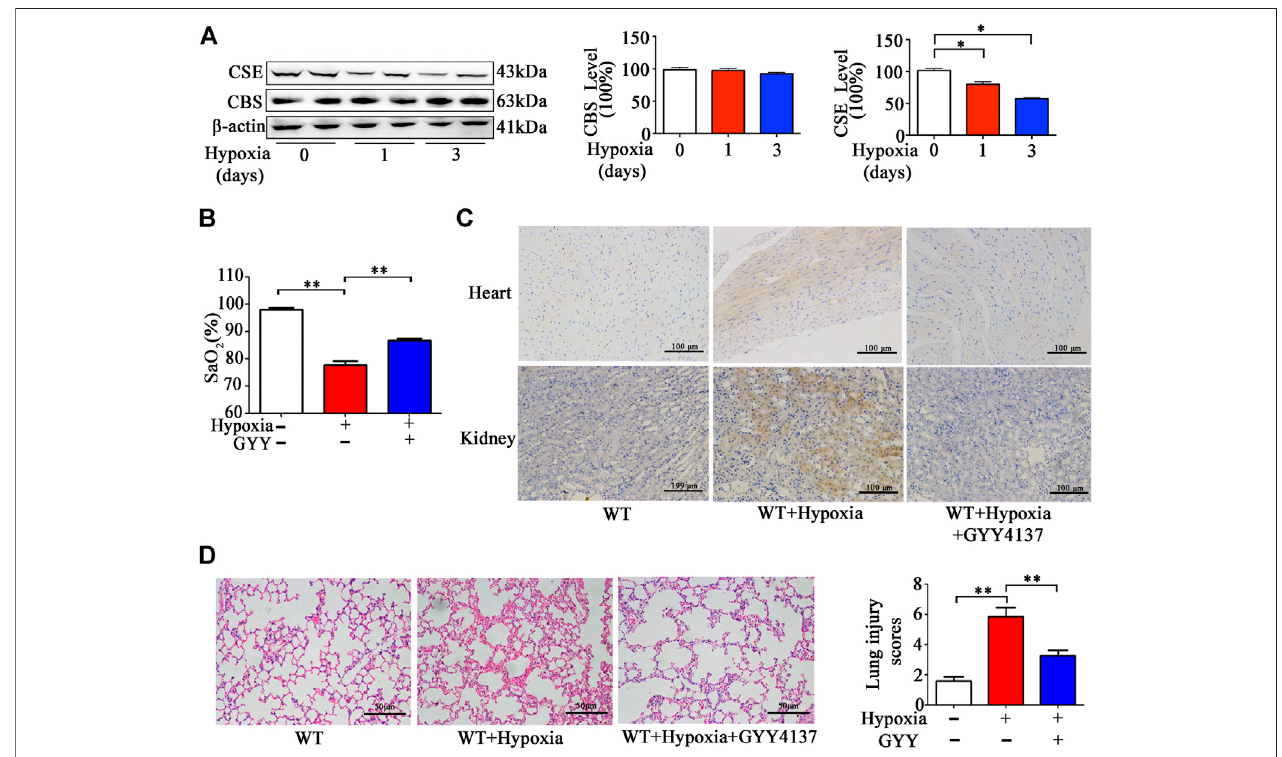
FIGURE7| GYY4137treatmentincreasesSaO 2 levelandattenuatespathologicalalternationinthelungsandHypoxyprobesignalsinheartandkidneysofthemice with hypoxia insult. (A) , CBS and CSE levels in lung tissues of the mice with hypoxia insult. Mice were exposed to normobaric hypoxia (10% oxygen) for the indicated times. Levels of CSE and CBS in lung tissues were determined by western blotting analysis. Representative protein bands are shown to the left of the cumulative histograms. ( B – D) , the effects of GYY4137 on SaO 2 and lung morphology in the mice with hypoxia insult. Mice were treated with GYY4137 (50mg/kg) and immediately subjected to normobaric hypoxia for 24h. Then, the mice were anesthetized for determination of SaO 2 level. (B) , Some mice were sacri fi ced at 30min after injection of Hypoxyprobe solution. Biopsies of kidneys, and heart were fi xed for Hypoxyprobe signals detection by using immunocytochemistry. (C) , panel: representative images of Hypoxyprobe signals in the hearts and kidneys. The lung tissues were collected and fi xed for H&E staining and lung injury scores were then calculated. (D) , Data are expressed as mean ± SEM; n (cid:2) 8 – 11 per group; * p < 0.05, ** p <